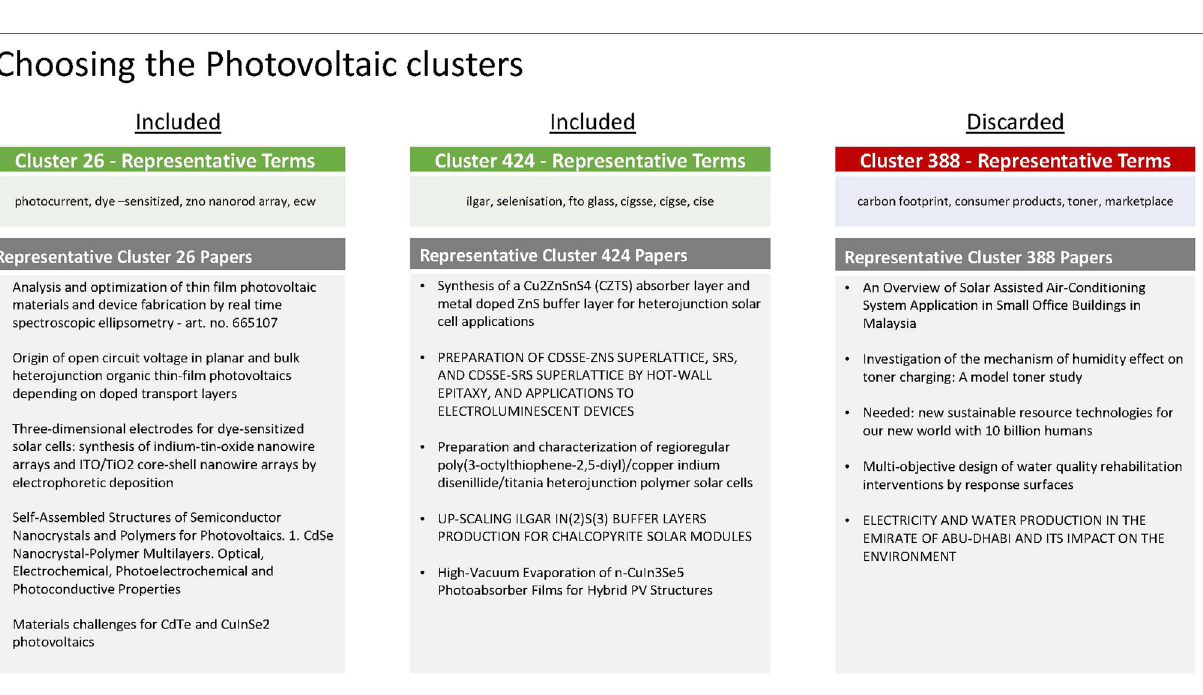
FigUre 10 | Three term clusters as an illustration of results and filtering step. Analysis of the terms and associated abstracts from the “top” three photovoltaic term clusters reveal that two are relevant while one is